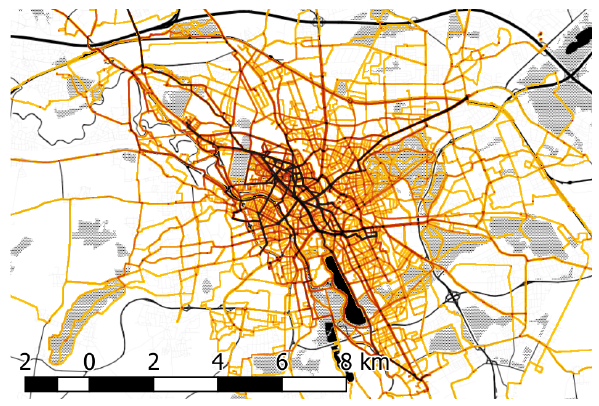
Figure 2. Trajectory heat map as overview for Hanover network exploration. (base map by Stamen Design, map data from OpenStreetMap)